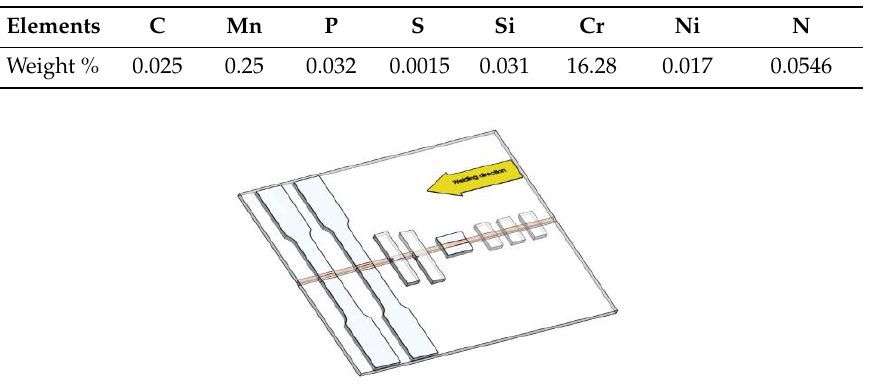
Figure 1. Test specimens for mechanical testing and weld morphology.